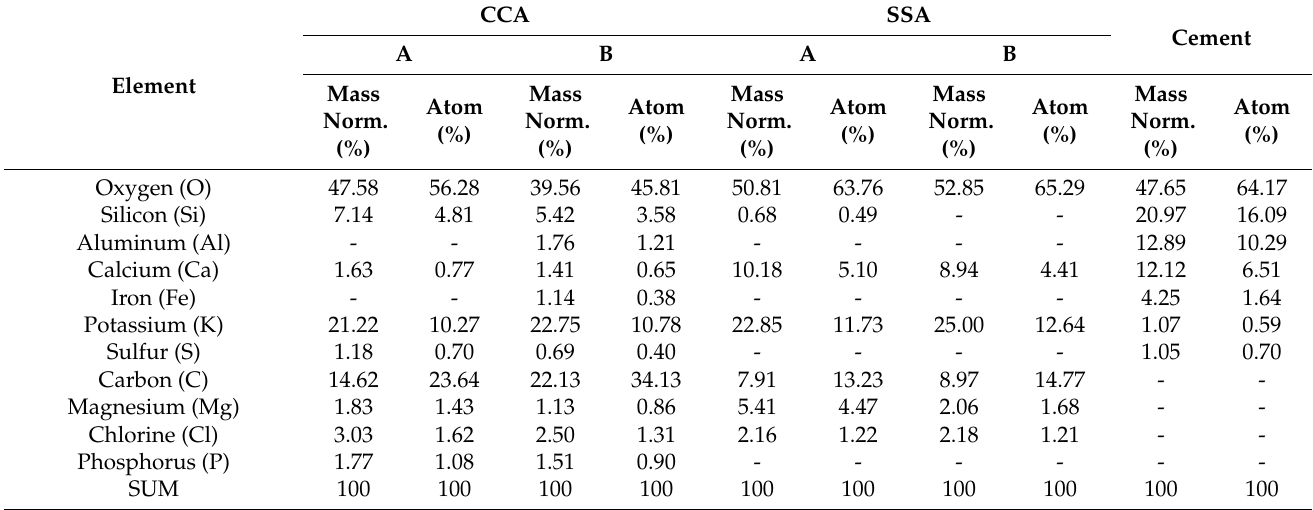
Table 3. CCA, SSA and cement elementary chemical composition, quantitative